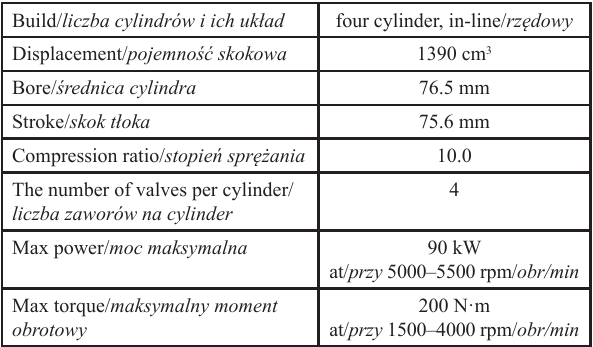
Table 1. Si engine-Volkswagen 1.4 TSi Tabela 1. Silnik o ZI – Volkswagen 1.4 TSI Build/ liczba cylindrów i ich układ